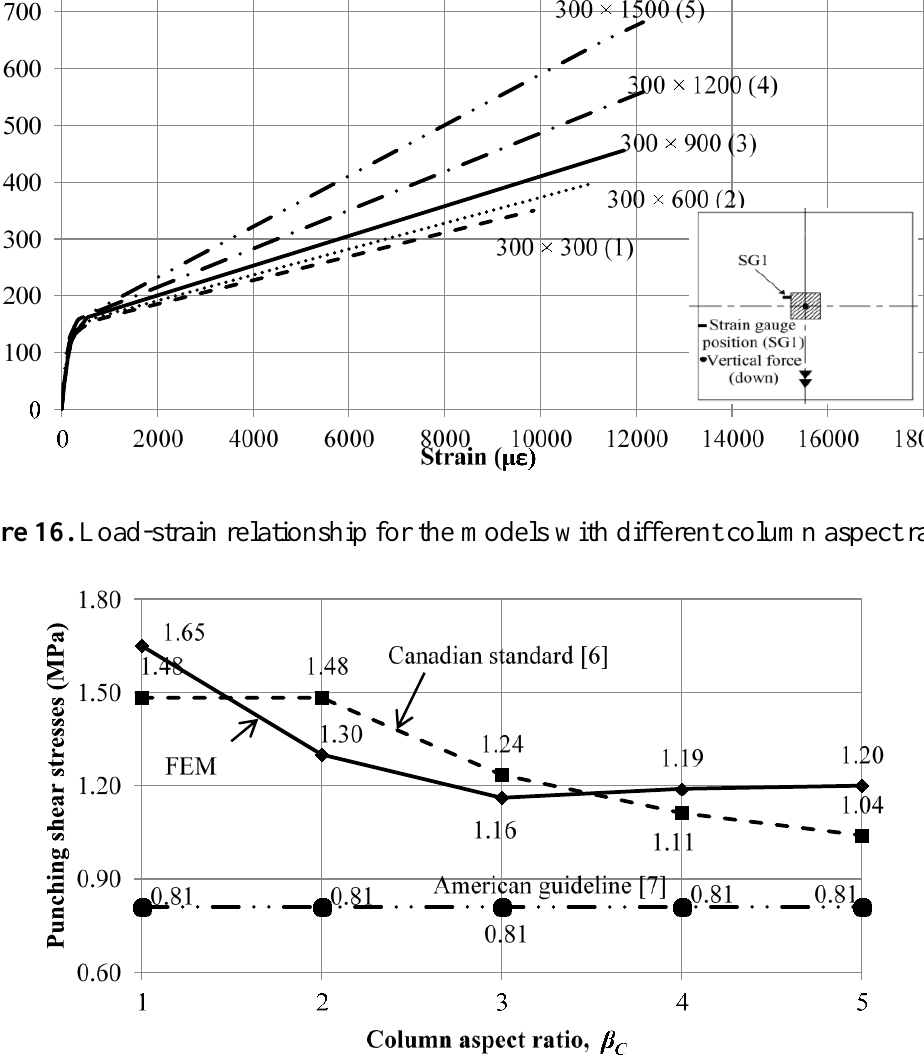
Figure 17. Relationship between the punching shear stress at failure and the column